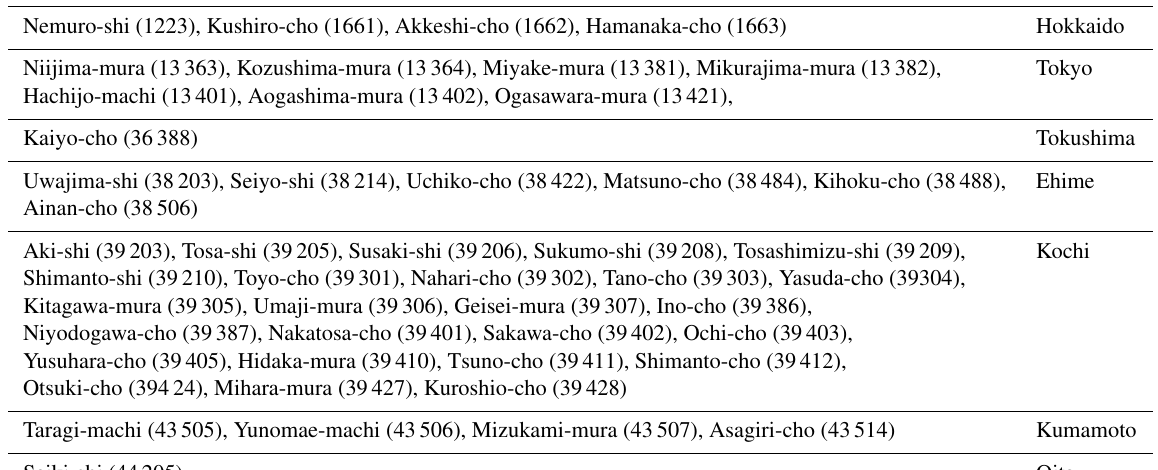
Table 5. A list of the top 100 clean air cities in Japan. The municipal number is shown in parenthesis. Municipality